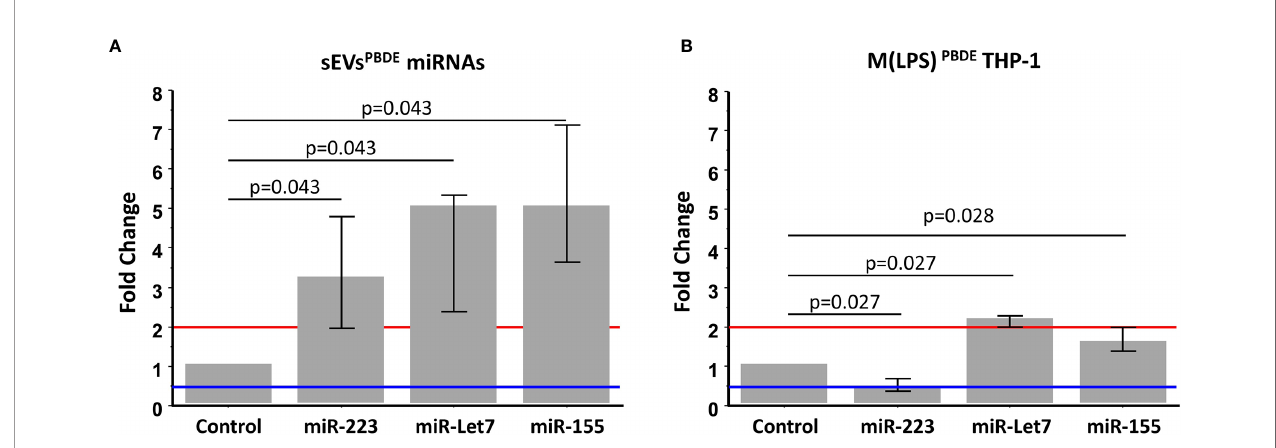
FIGURE 5 | Real Time PCR analysis. Expression pro fi le of miR-223, miR-let7a, and miR-155 in sEVs PBDE (A) and M(LPS) PBDE THP-1 cell line (B). Vertical bars represent medians and interquartile ranges. Red horizontal lines de fi ne a statistically signi fi cant fold increase (fold change >2), blue lines de fi ne under-regulated expression levels (fold change < 0.5). Differences from control (DMSO) were evaluated by means of Wilcoxon signed rank